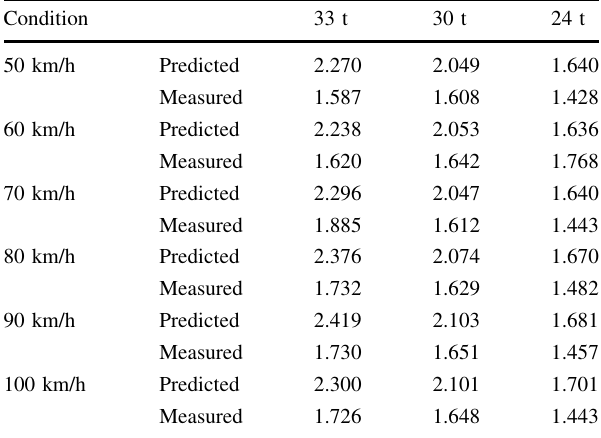
Table 2 Contrast of maximum deflection of bridge between mea- sured and predicted values (Unit: mm) Condition